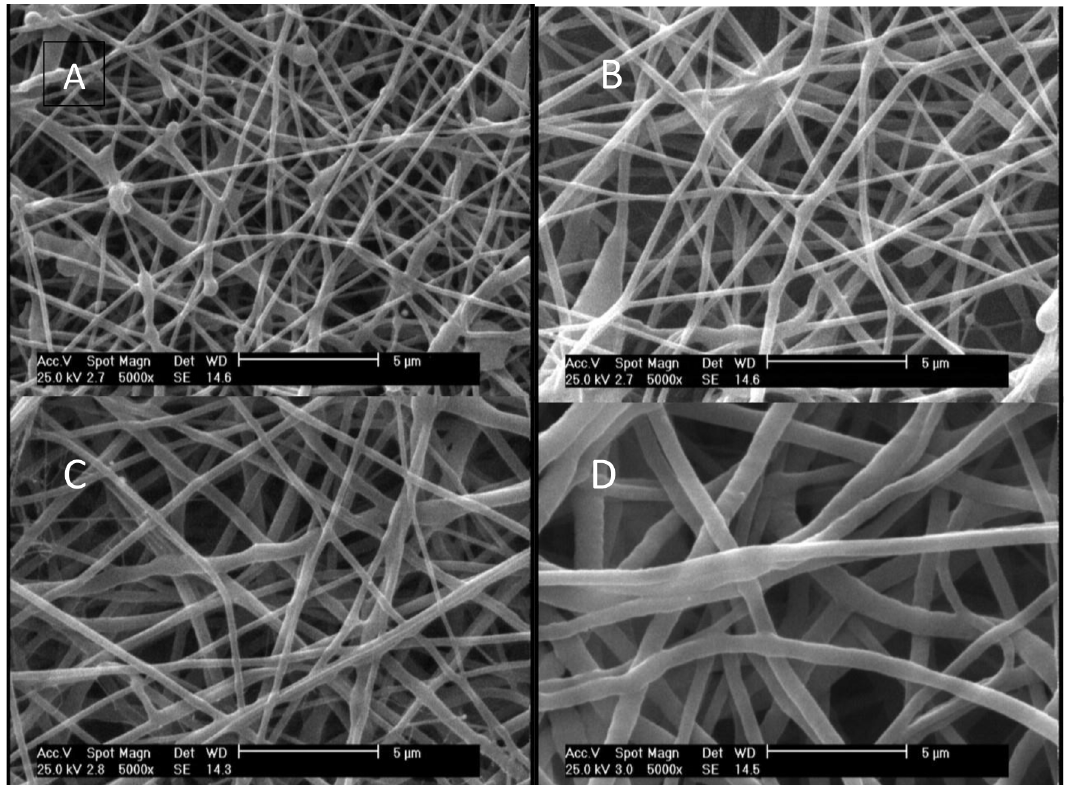
Fig. 2. Morphology of Cur-PCL nanofibers in deferent concentrations of solution A) 6% B) 7% C) 8 % and D)